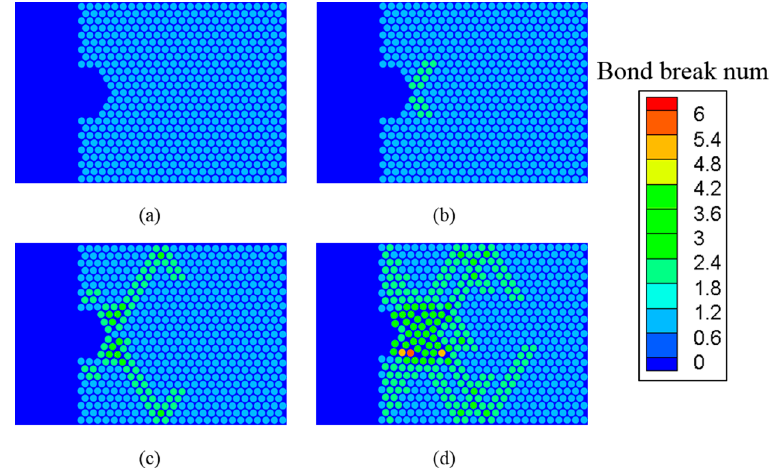
Figure 10. The process of sand production in cemented granular media. ( a ) Initially, the sample is intact with no bonding breakage; ( b ) the bond near the cavity begins to be broken; ( c ) small cracks propagate into the sample leading to the localized failure near the cavity; ( d ) the flow erodes the localized failure zone.